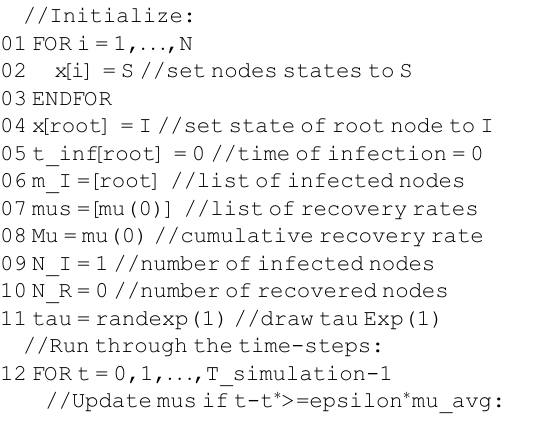
Pseudocode 2: Pseudocode for a non-Markovian SIR process with non-constant recovery rates. The function returns the instantaneous recovery rate as function of ( t − t (cid:6) ); for Weibull distributed recovery times, is given by Eq (23). C++ code is given in S1